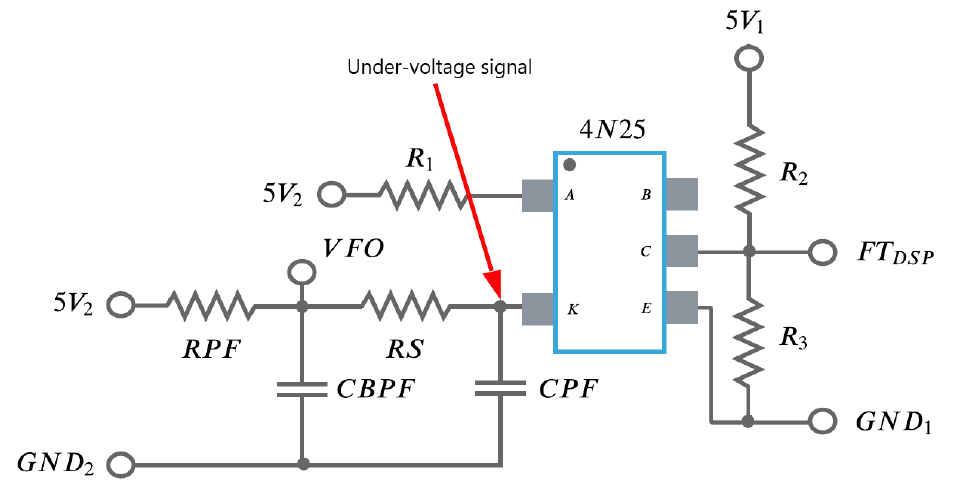
Figure 6. FNA41560 under-voltage detection circuit